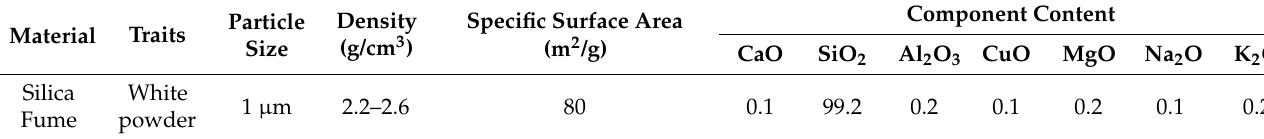
Table 3. The component content of silica fume.